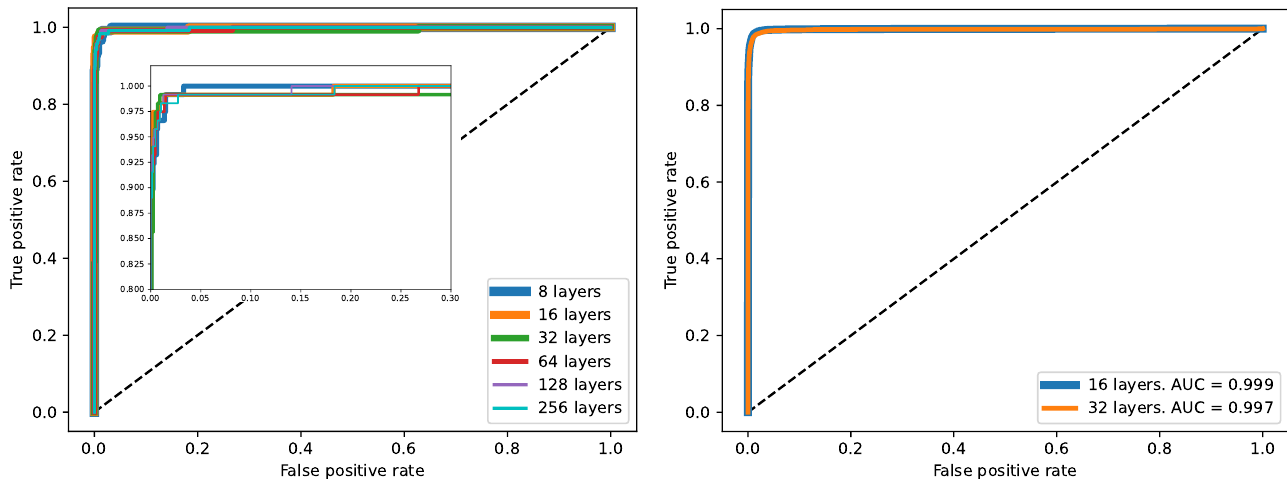
Figure 17. ROC curves for the training ( left ) and testing ( right ) stages of CNNs with the same architecture but different arrangement of input data. See the text for details.